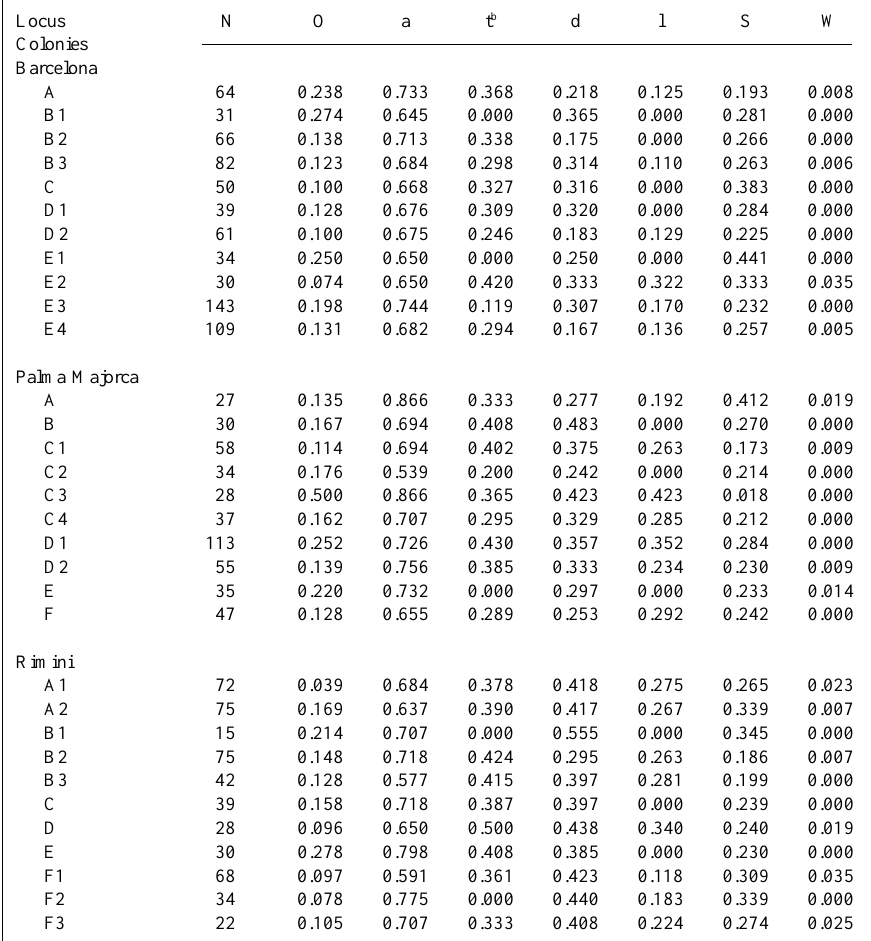
Table I - Genetic profiles of natural domestic cat colonies and subpopulations studied in Barcelona (Iberian), Palma Majorca (Balearic Islands), Rimini (Italy) and Buenos Aires (Argentina) for seven loci. N = Sample size. O = orange; a = non-agouti; t b = blotched tabby; d = dilution; l = long hair; S = white spotting; W = dominant white. Locus N O Barcelona